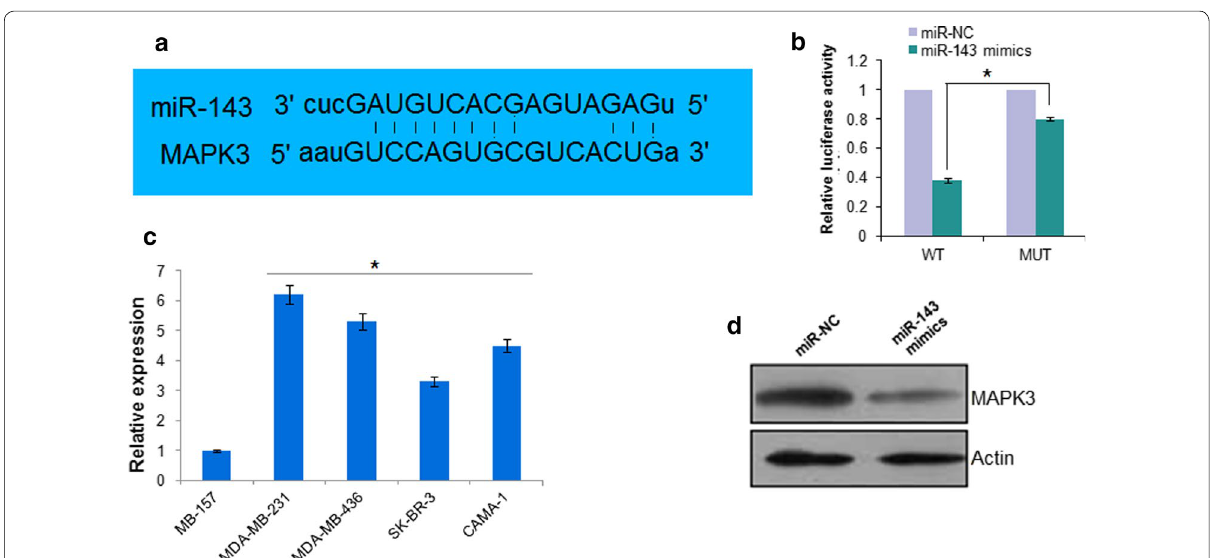
Fig. 4 a Bioinformatic analysis using TargetScan software (http://www.targe tscan .org) showing MAPK3 as the target of miR-143. b Dual luciferase. c Expression of MAPK3 in normal and breast cancer cells. d Western blot analysis showing the expression of MAPK3 in miR-NC and miR-143 mimics transfected CAMA-1 cells. The experiments were performed in triplicate and expressed as mean